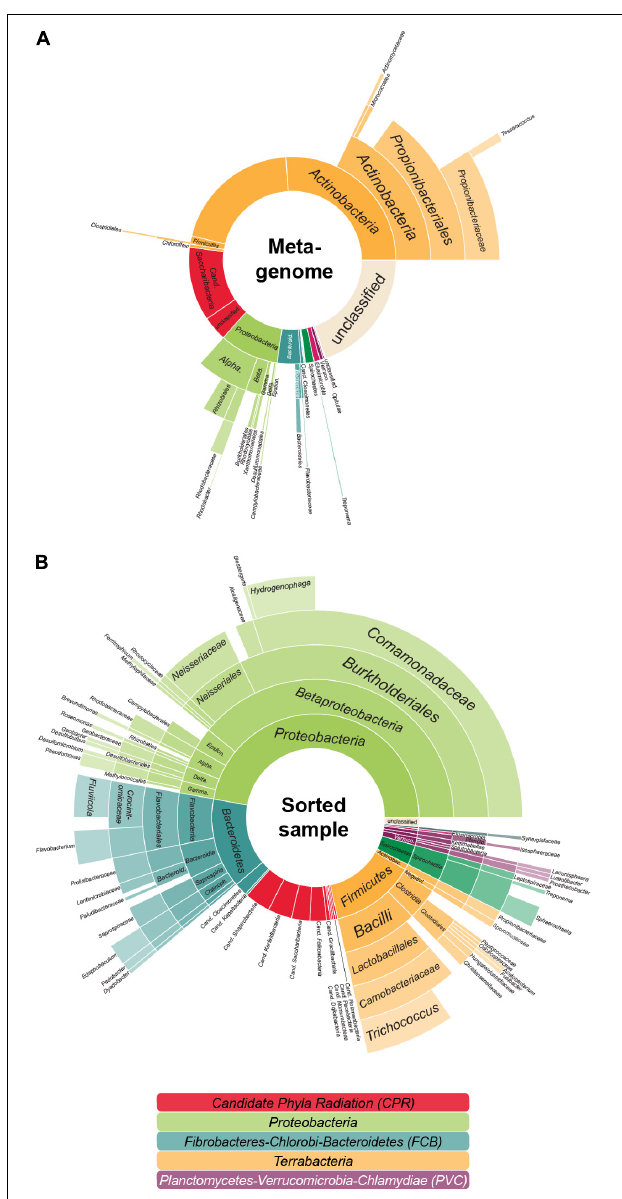
FIGURE 1 | The aerated lagoon (LEA) of a winery wastewater treatment plant—before and after sorting. (A) Microbial community composition. In total, 26.4 GB of shotgun metagenomic sequencing data of the sample were processed, assembled and analyzed based on the phylogenetic classification of all attributable marker genes. In total, 291,396 marker genes could be identified. (B) Taxonomic composition of cells after cell sorting. Relative proportion of the covered taxa by 16S rRNA gene sequencing inferred for those sorted cells accessible to cell lysis, whole genome amplification and PCR. In total, 359 evaluable Sanger sequencing reads were gained from 880 sorted cells. The colors reflect the higher-level unranked taxa/superphyla encompassing the different